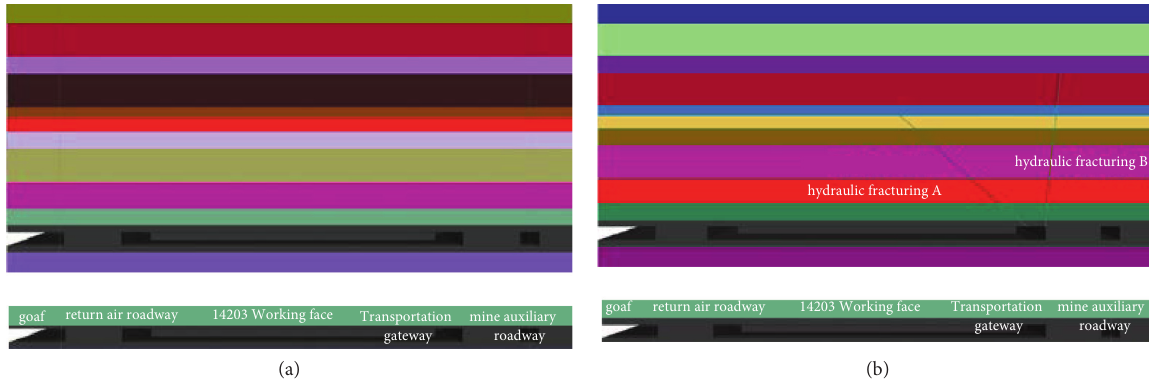
Figure 6: Excavation space relationship diagram of the model. (a) Nonhydraulic fracturing. (b) Hydraulic fracturing. Zone ZZ Stress Calculated by: Volume